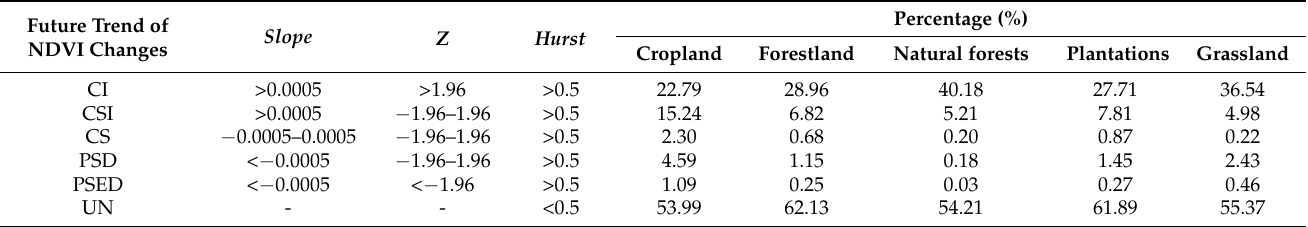
Table 5. Future NDVI trends of different vegetation types in the MRYR from 1999 to 2015.